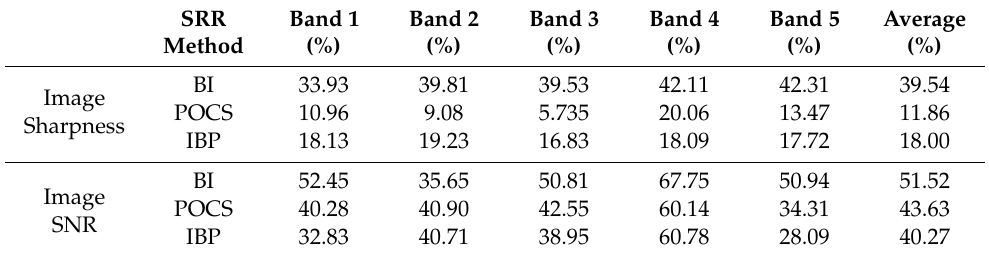
Table 10. The percentage improvements in the sharpness and SNR of the SRR image obtained using the MSR-NCHOTV method relative to those of the SRR images obtained using the BI, POCS, and IBP